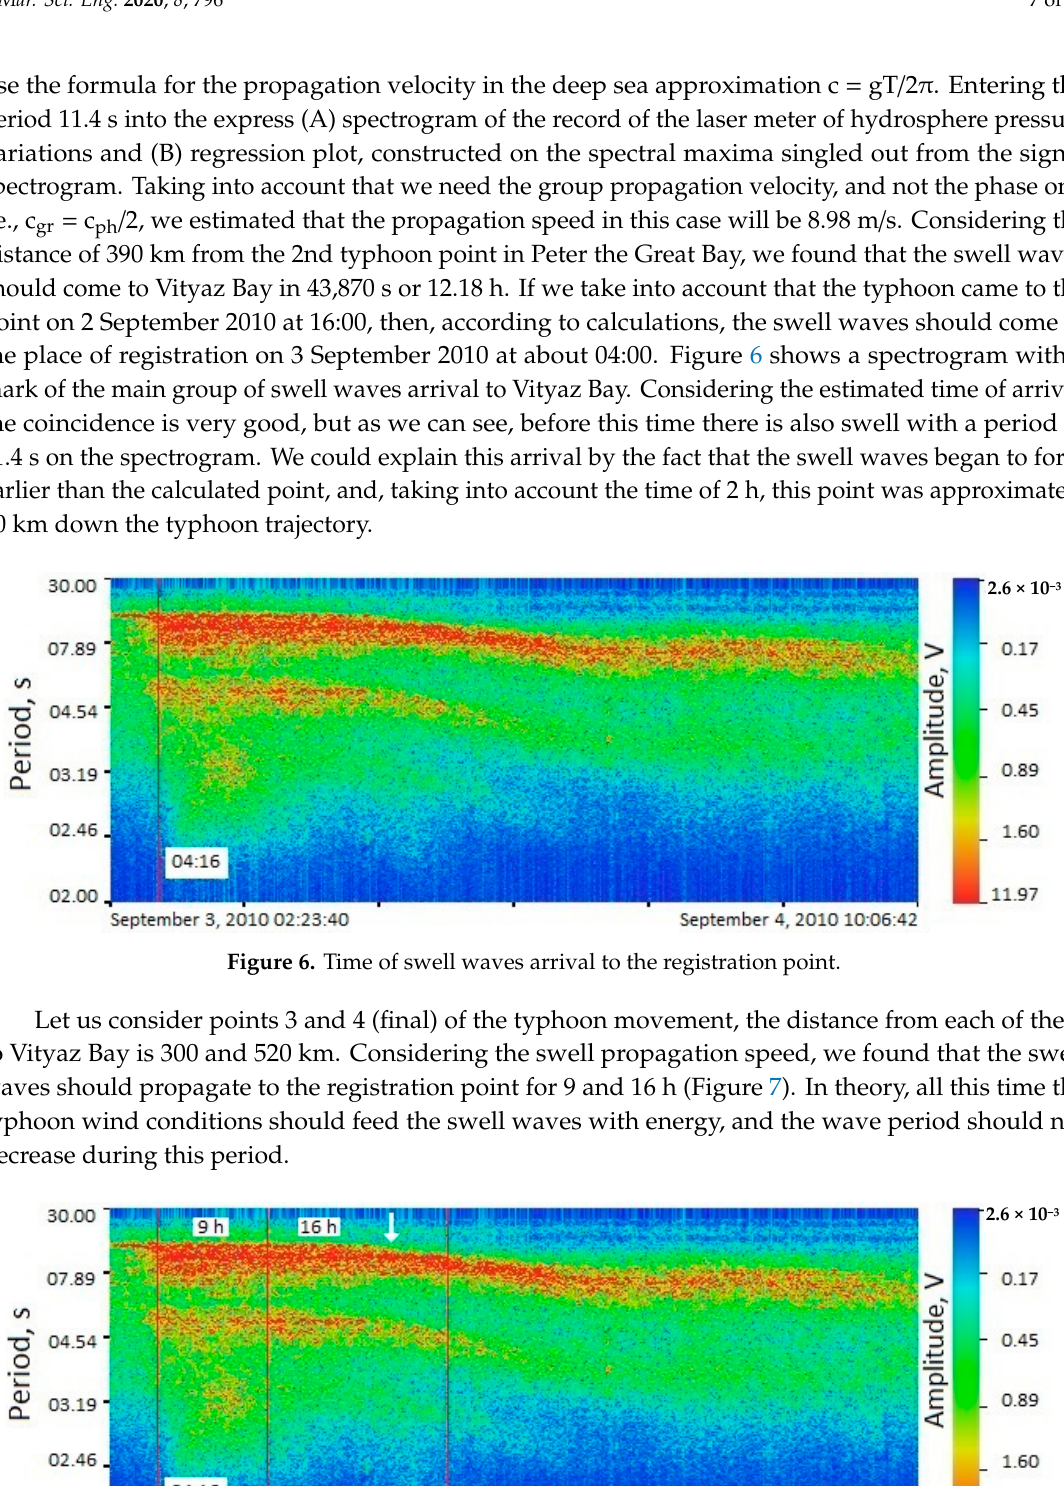
Table 1. Regression analysis evaluation criteria. R 2